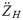
A typical example of the vertical heel point acceleration Z¨H in the same figure as vertical ground reaction force FZ as reference (same measurement as in Figs 3 and 4).As in Fig 4 the start of impact is shown by a vertical dotted line indicated by t0, the instant of the vertical force peak is indicated by tp and the end of heel strike, which is defined as zero vertical heel velocity, by te. Here also the gravitational acceleration g is shown.